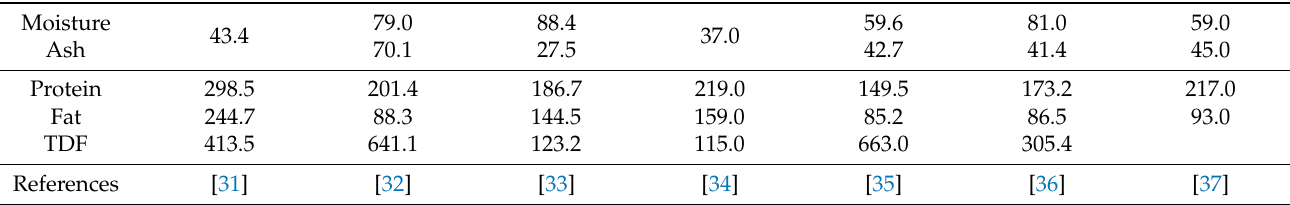
Table 1. Nutritional content of tomato pomace (g/kg).